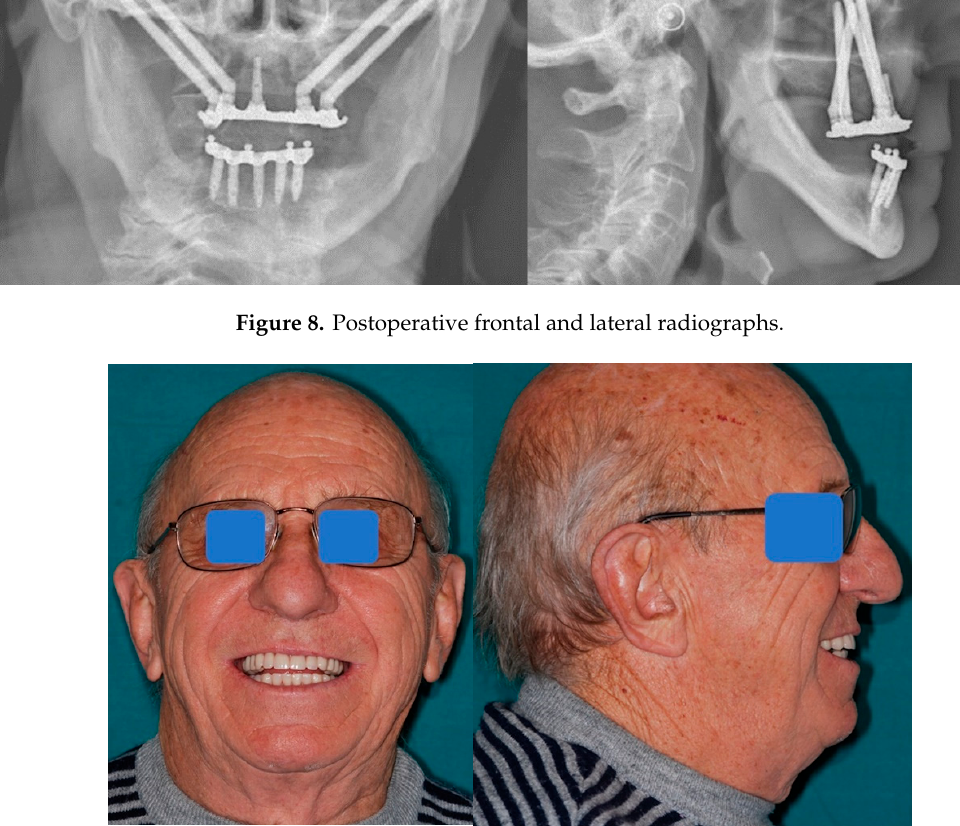
Figure 9. Postoperative frontal and lateral view of the patient.